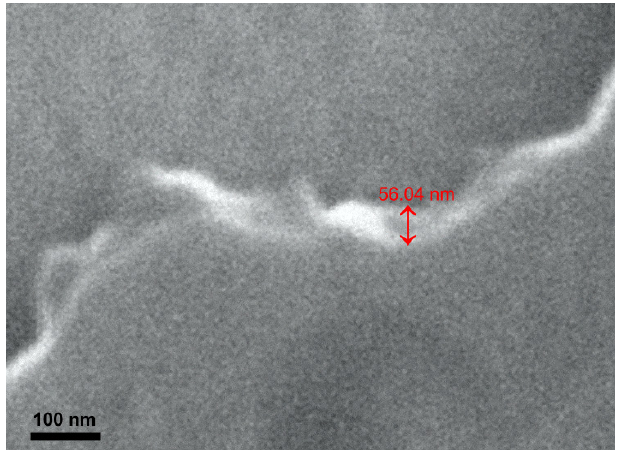
Figure 11. SEM images of the transversal cross section of 25MgHAp coatings.